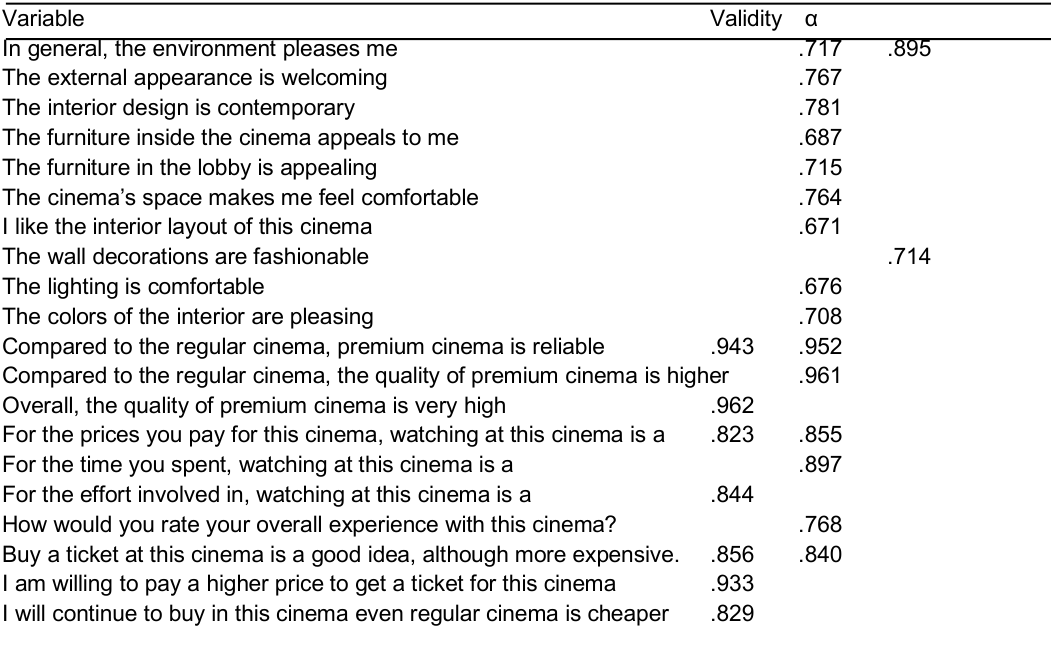
Table 2: Validity Testing &